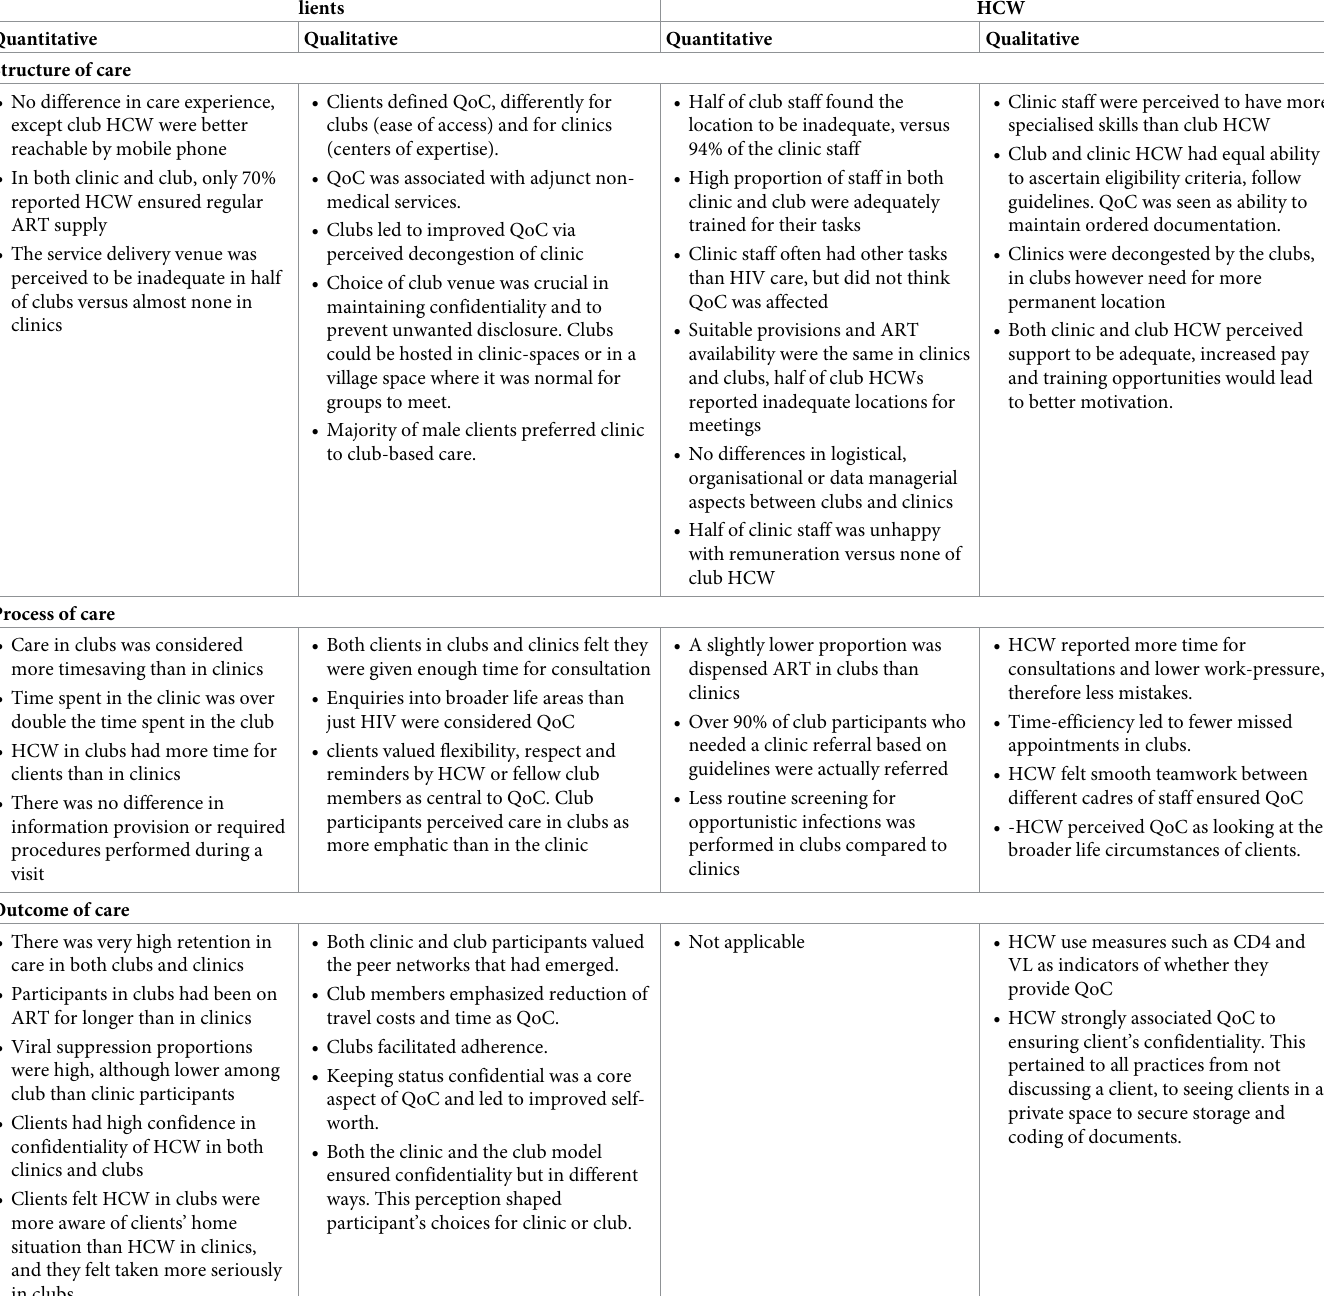
Table 6. Joint display table summarizing quantitative and qualitative results by structure, process, and outcome.